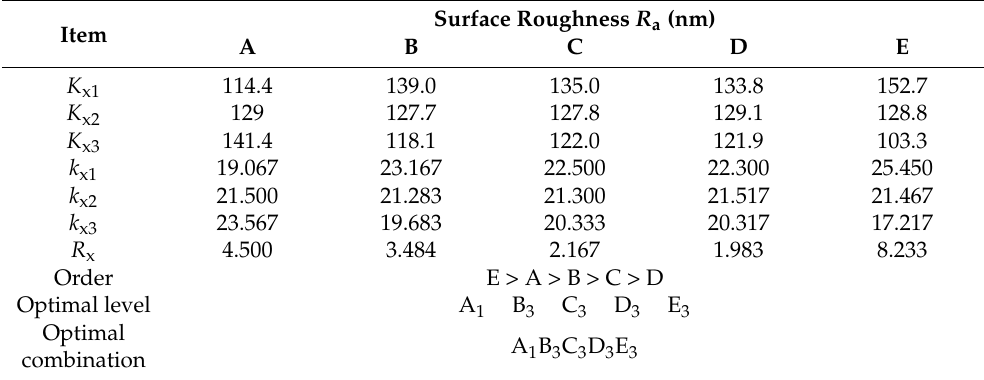
Table 3. Intuitive analysis table for surface roughness R a .